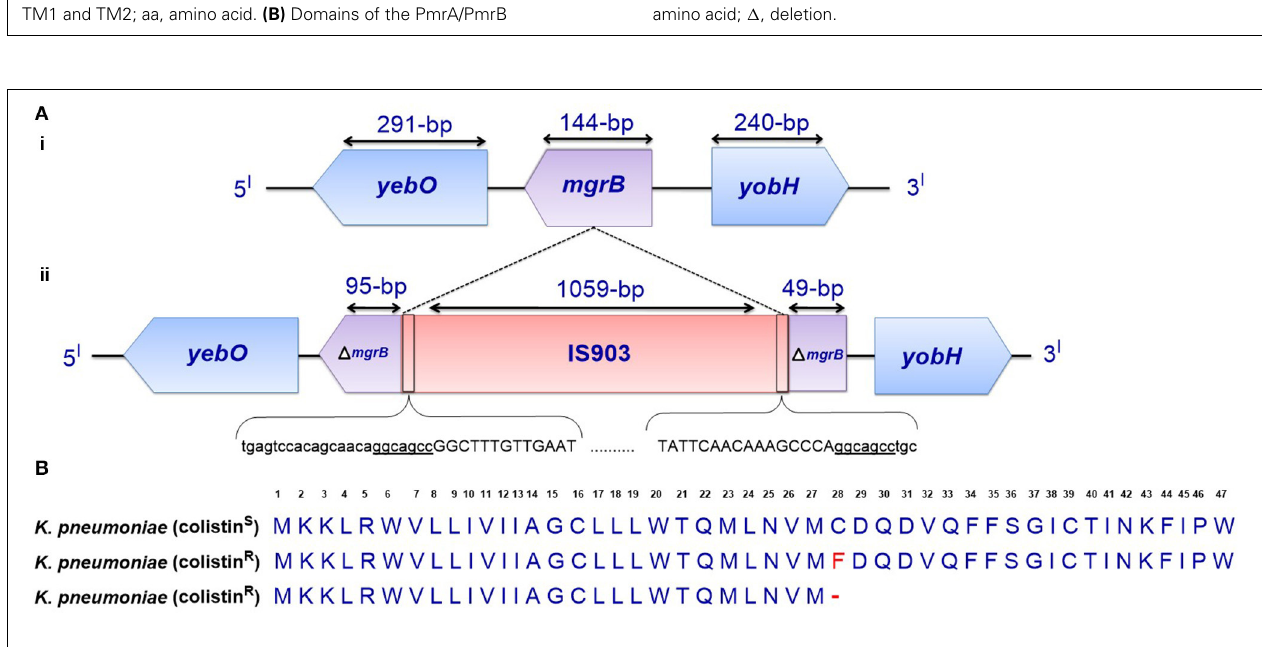
FIGURE 2 | (A) Domains of the PmrA/PmrB two-component system and positions of all mutations conferring polymyxin resistance to Salmonella enterica serovar Typhimurium. PmrA domains , cheY-homologous receiver domain [REC]; aa 1–112. Transcriptional regulatory protein, C-terminal domain [Trans_reg_C]; aa 145–216. PmrB domains , First transmembrane domain [TM1]; aa 13–35. d Periplasmic domain [PD]; aa 35–66. Second transmembrane domain [TM2]; aa 66–88. Histidine kinases, adenylyl cyclases, methyl-binding proteins, and phosphatases [HAMP domain]; aa 89–141. Histidine kinase A (phosphoacceptor) domain [HisKA]; aa 142–202. Histidine kinase-like ATPases [HATPase_c]; aa 249-356. ∗ HisKA, with the active site at H148 in PmrB of Salmonella enterica subsp. enterica serovar Typhimurium str. LT2 (GenBank accession no. AE006468). d Periplasmic domain was not predicted in SMART but was assumed to be between the TM1 and TM2; aa, amino acid. (B) Domains of the PmrA/PmrB